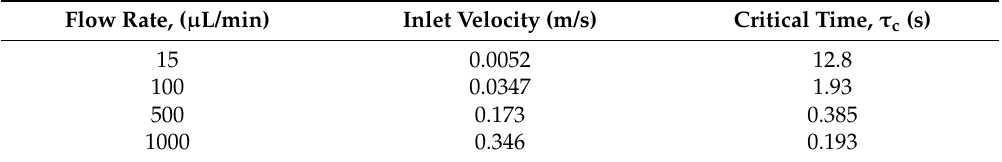
Table 2. Flow rate, inlet velocity, and critical time for explored scenarios.